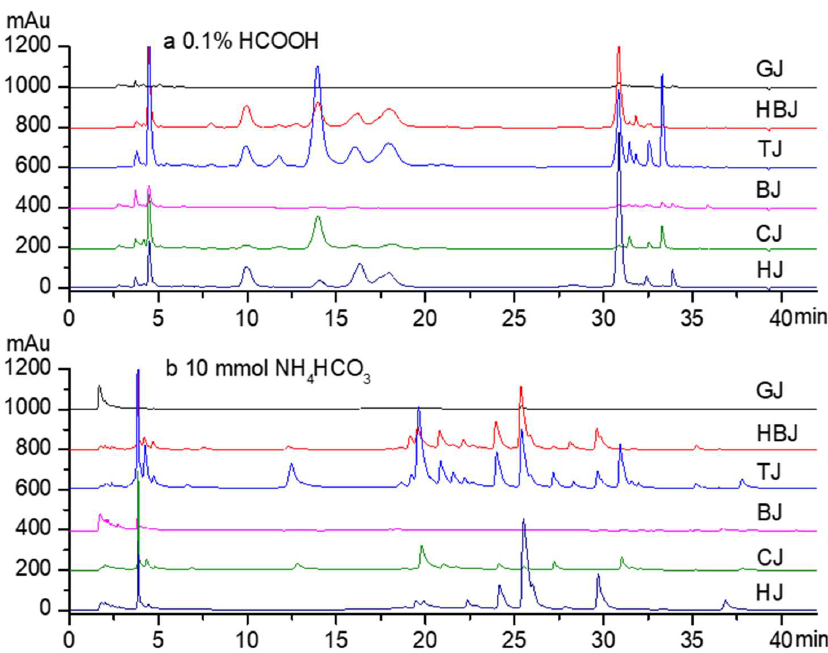
Figure 1. HPLC analysis of the components from Chrysanthemum morifolium tea for acidic and basic conditions. The gradient elution solvents consisted of phase A and phase B (acetonitrile). ( a ) Phase A water with 0.1% formic acid, and ( b ) phase B was water with 10 mmol / L ammonium hydrogen carbonate. GJ, C. morifolium ‘Gongju’; HBJ, C. morifolium ‘Hangbaiju’; TJ, C. morifolium ‘Taiju’; BJ, C. morifolium ‘Boju’; CJ, C. morifolium ‘Chuju’; HJ, C. morifolium